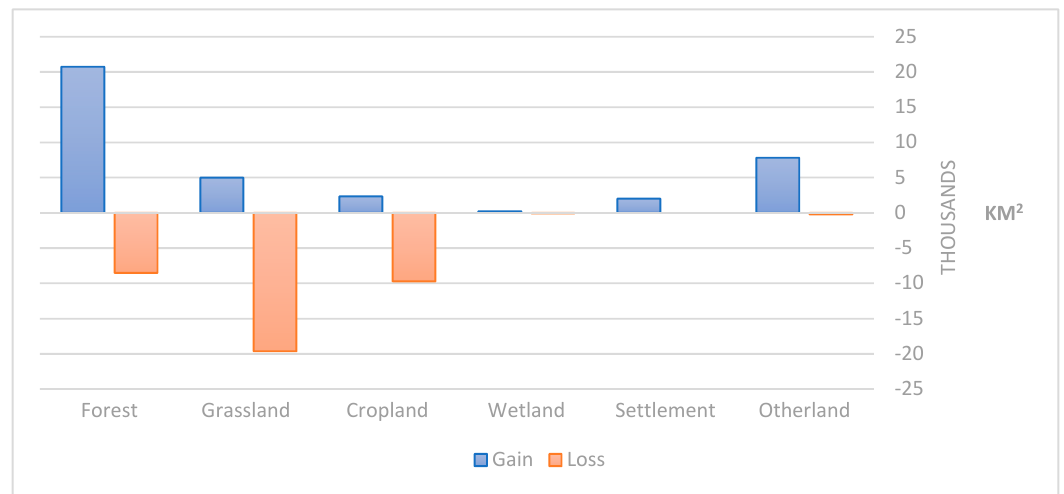
Figure 10. Gain and loss of land cover classes in mountain areas in countries where MGCI decreased from 2015 to 2018.